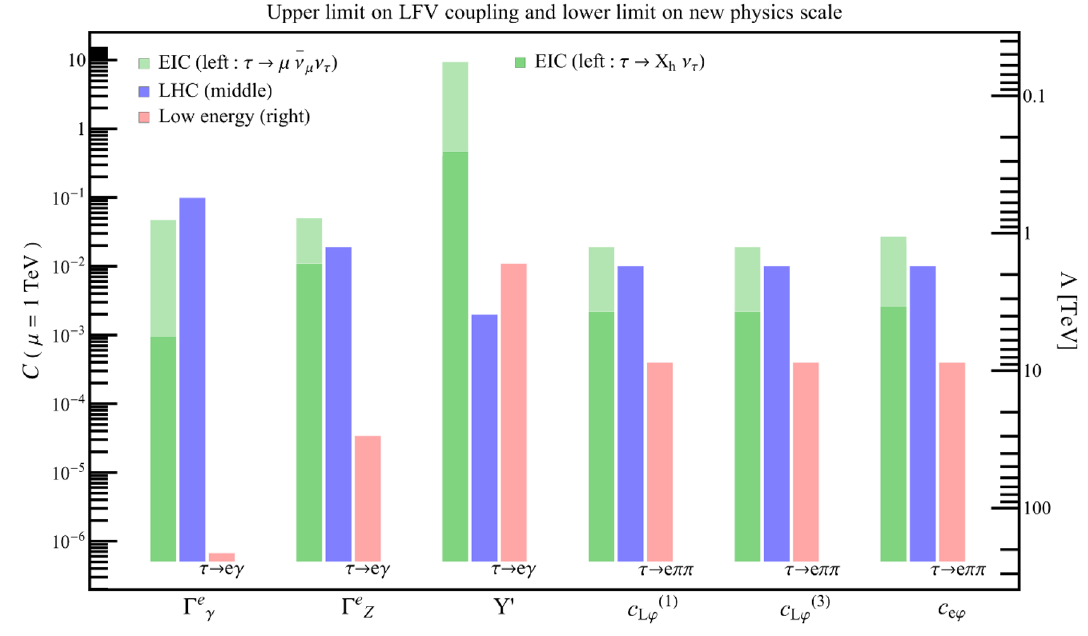
and c from the EIC (light green, left), LHC (blue, , Y 0 , c (1 , 3) eϕ e γ,Z Lϕ